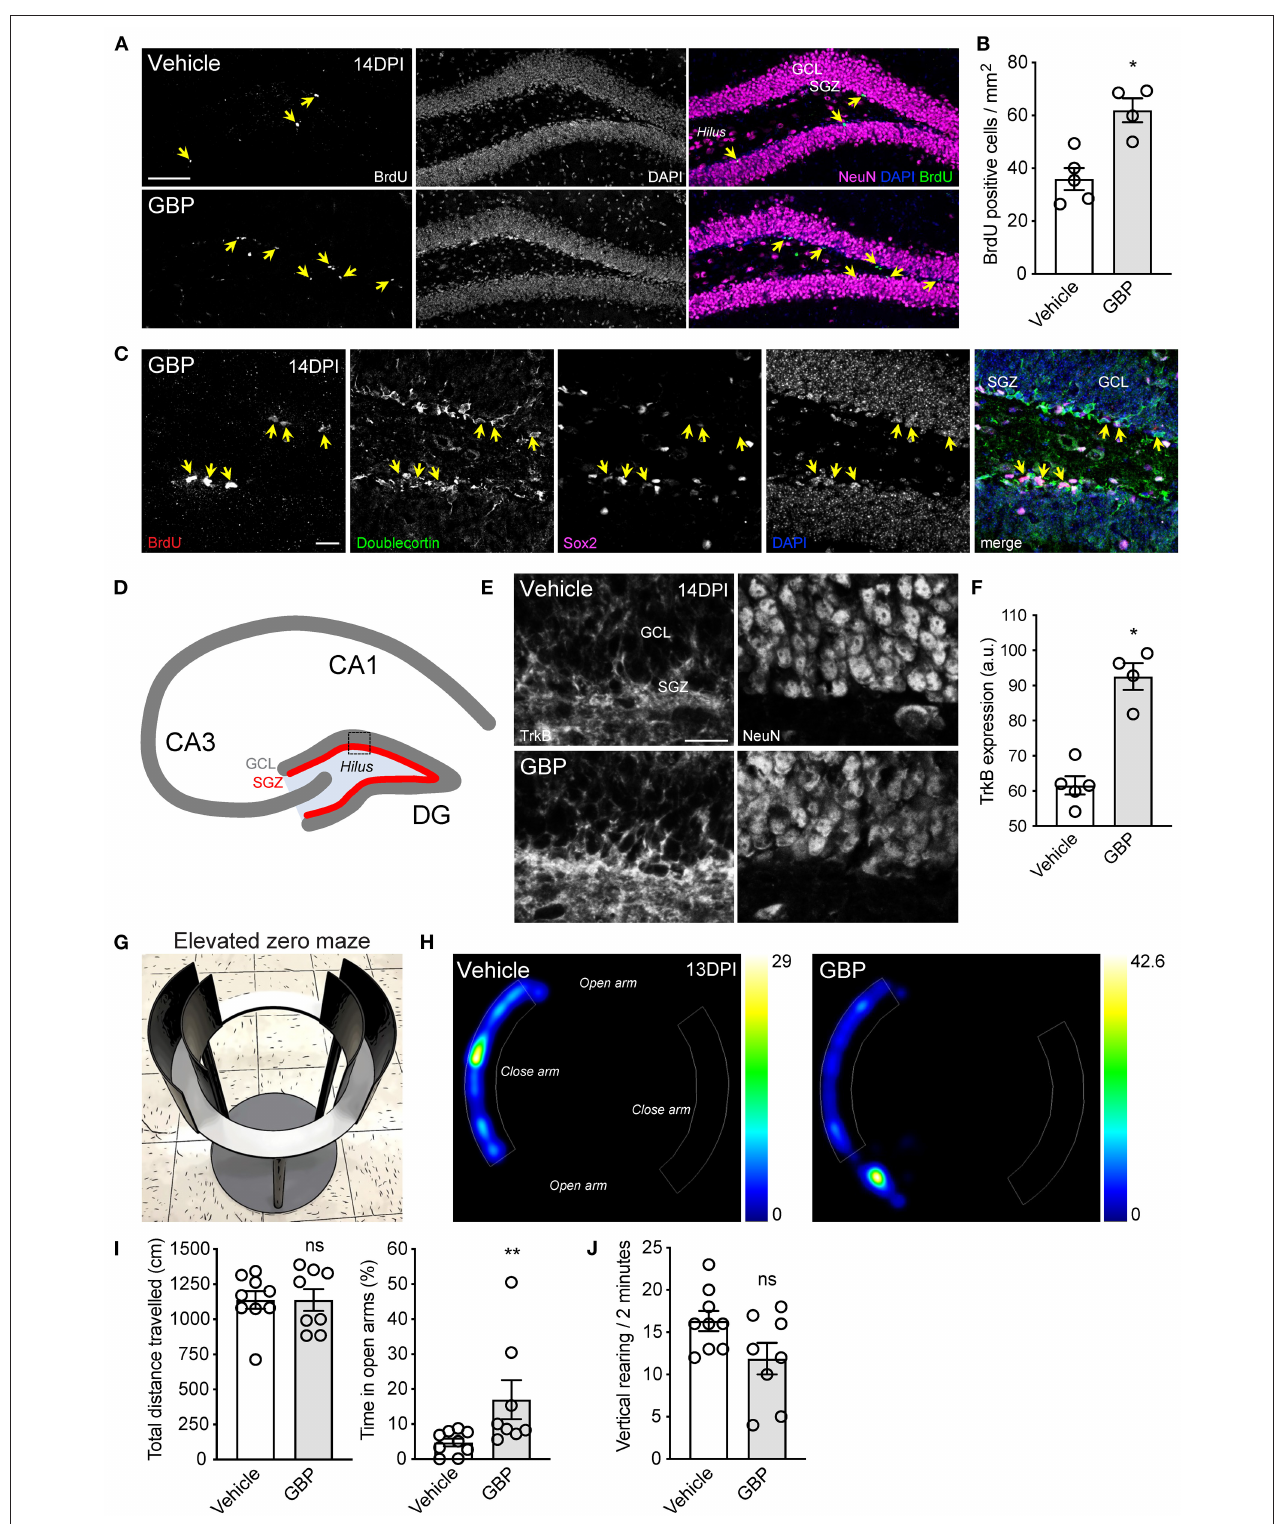
FIGURE 7 | Chronic administration of GBP promotes hippocampal neurogenesis and counteracts anxiety-like behavior. (A) Representative fluorescence images of hippocampal sections from adult mice 14 DPI. Yellow arrows indicate BrdU positive cells in the subgranular zone (SGZ) of the dentate gyrus (GCL: granule cell layer). Scale bar, 100 µ m. (B) Quantification of (A) . Mean and SEM (Wilcoxon rank sum test, * p < 0.05, vehicle n = 5 and GBP n = 4). (C) Representative fluorescence